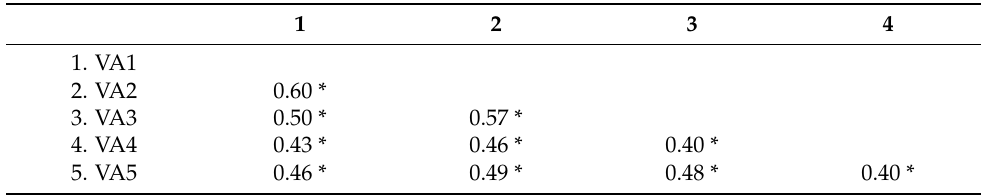
Table 1. Spearman correlations among verbal aggression